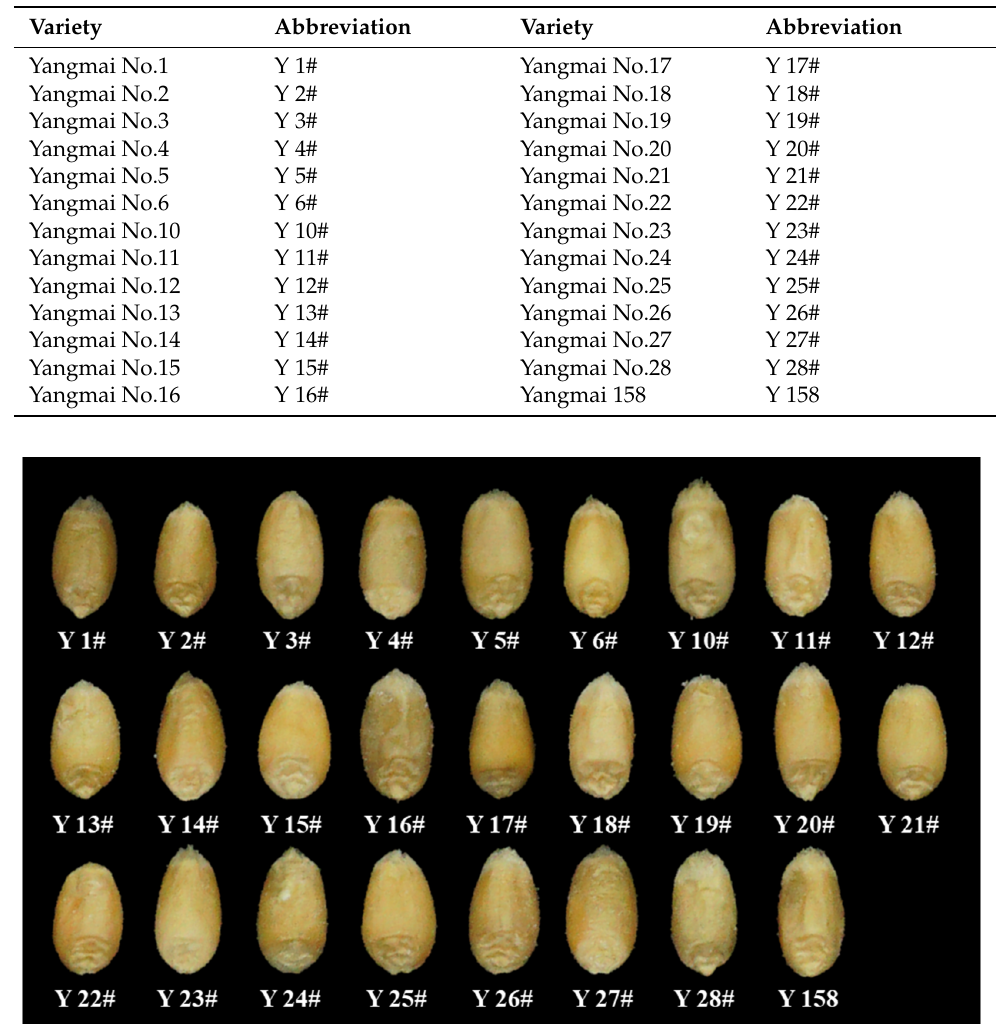
Figure 1. Wheat grains of different Yangmai series varieties.